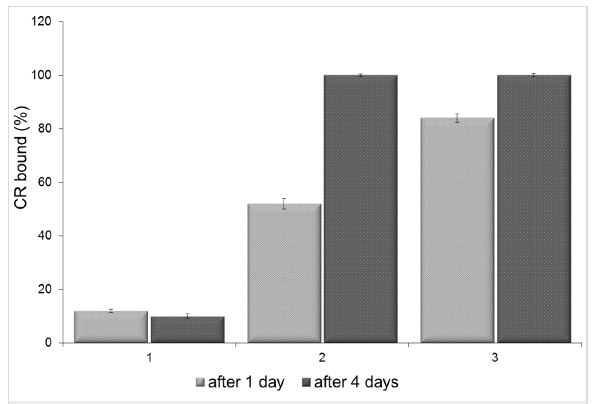
In Figure 3, 100% equals the total amount of CR added to the sample (1 mL of 2 mg/mL CR added to 1 mg of SWNTs, fol- lowed by sonication and filtration, as described in the Experi- mental part).